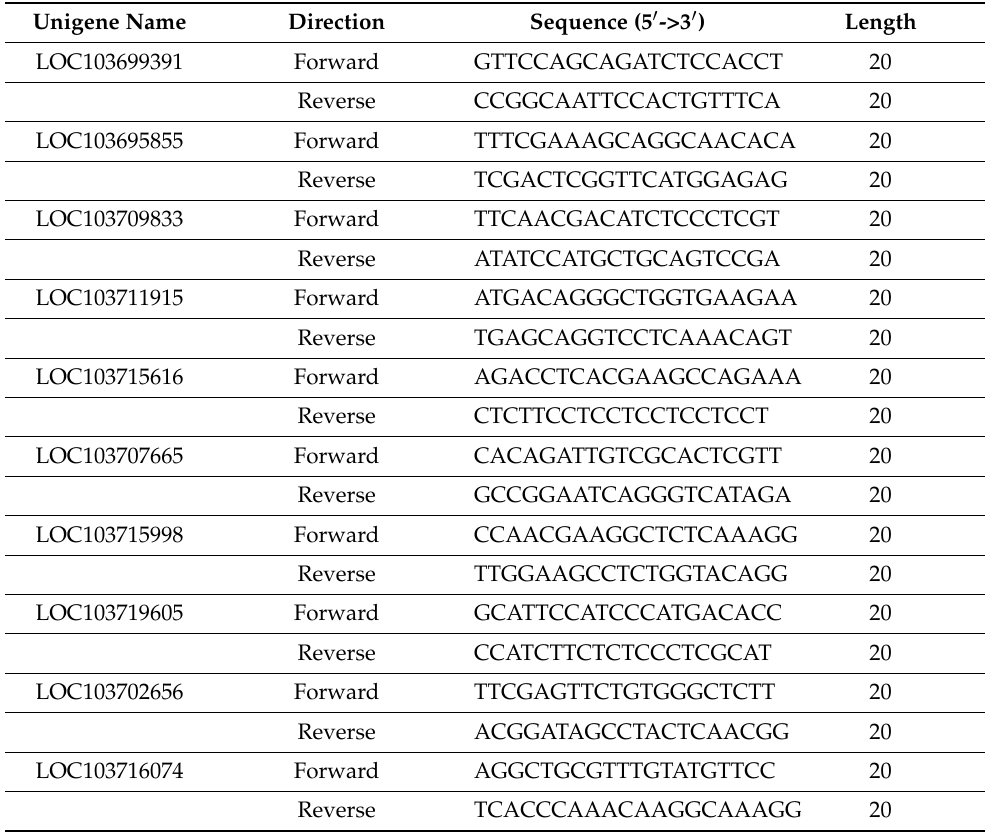
Table 5. RT-qPCR primers used for validation